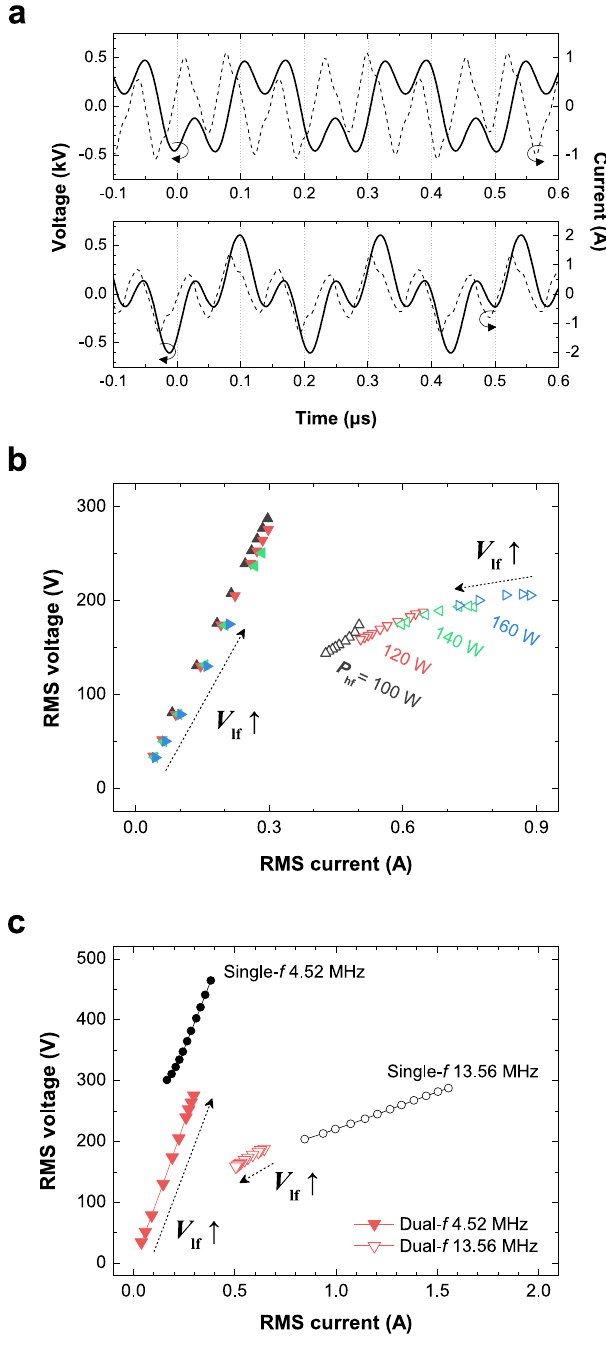
Figure 2. Electrical characteristics of dual-rf argon capacitive discharges. ( a ) Dual-frequency waveforms of the discharge voltage and current with 0° (top) and 180° (bottom) phase differences between the hf and lf voltage components. ( b ) V RMS - I RMS characteristics of the lf (solid symbols) and hf (open symbols) components with a 0° phase difference and various P hf . ( c ) I RMS - V RMS characteristics of dual- and single-frequency capacitive discharges. For clarity, data in b and c are only shown as the mean value for all panels (n = 5). The standard deviations of the y -axis data were < 1% of the mean